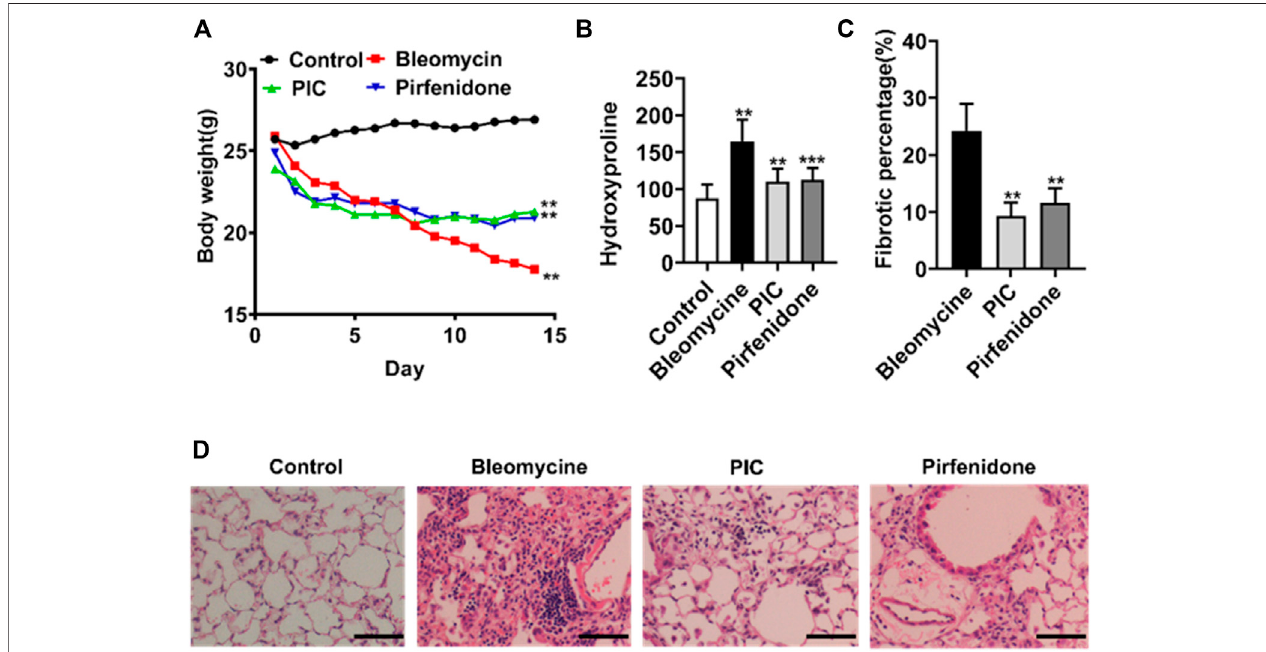
FIGURE 4 | (A) Representative images showing the weight changes of therapeutic dosing of 10 mg/kg PIC in mice with the established bleomycin-induced pulmonary fi brosismodel. (B) Hydroxyprolinecontentoflungtissuesfromindicatedgroupsofmice. (C,D) Hematoxylin-eosinstainingandpulmonary fi brosisareaoflung sections from the indicated groups of mice. Scale bars, 100 µm. Data are expressed as mean ± SD, n = 6. ** p <